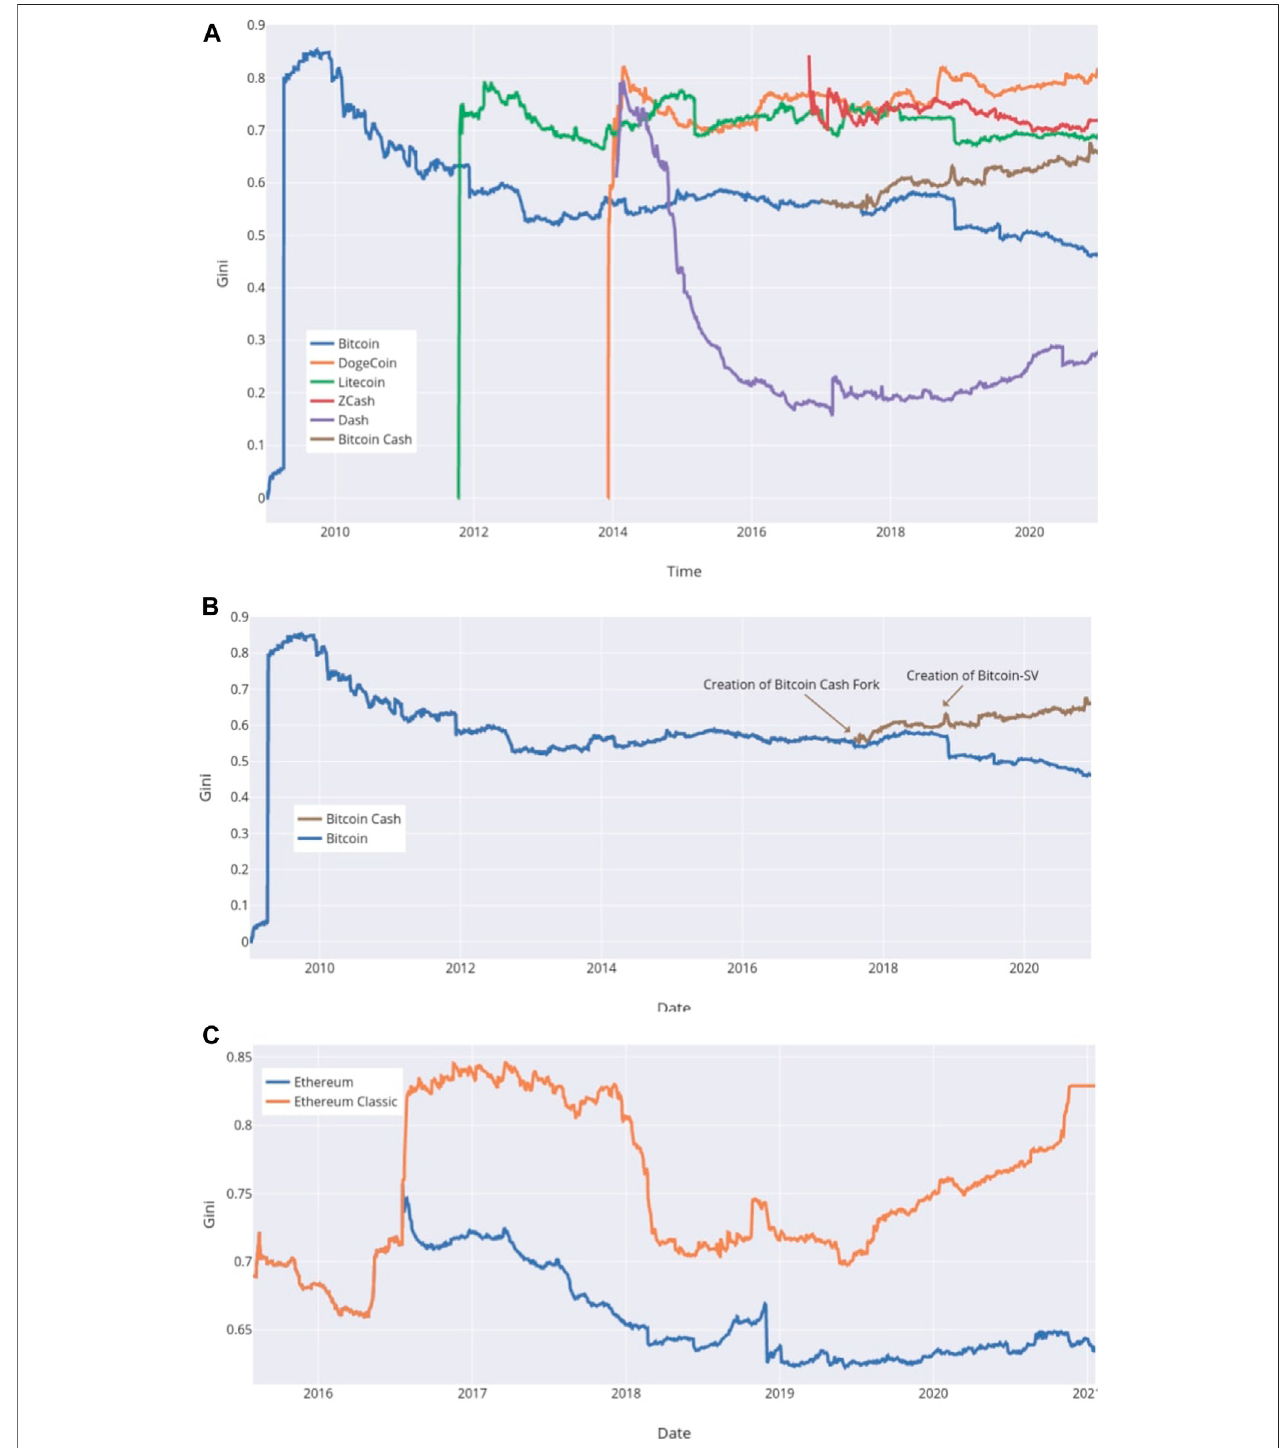
FIGURE 3 | ERD diagram for Bitcoin-Like Cryptocurrencies.